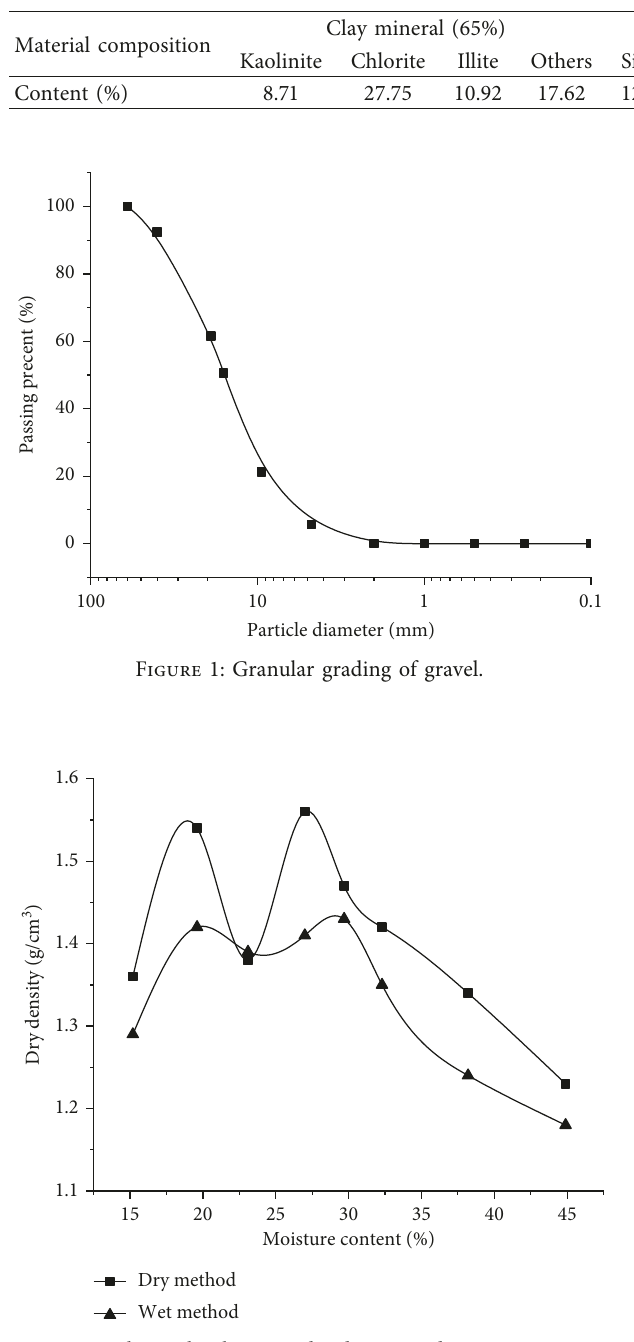
Figure 2: Relationship between dry density and moisture